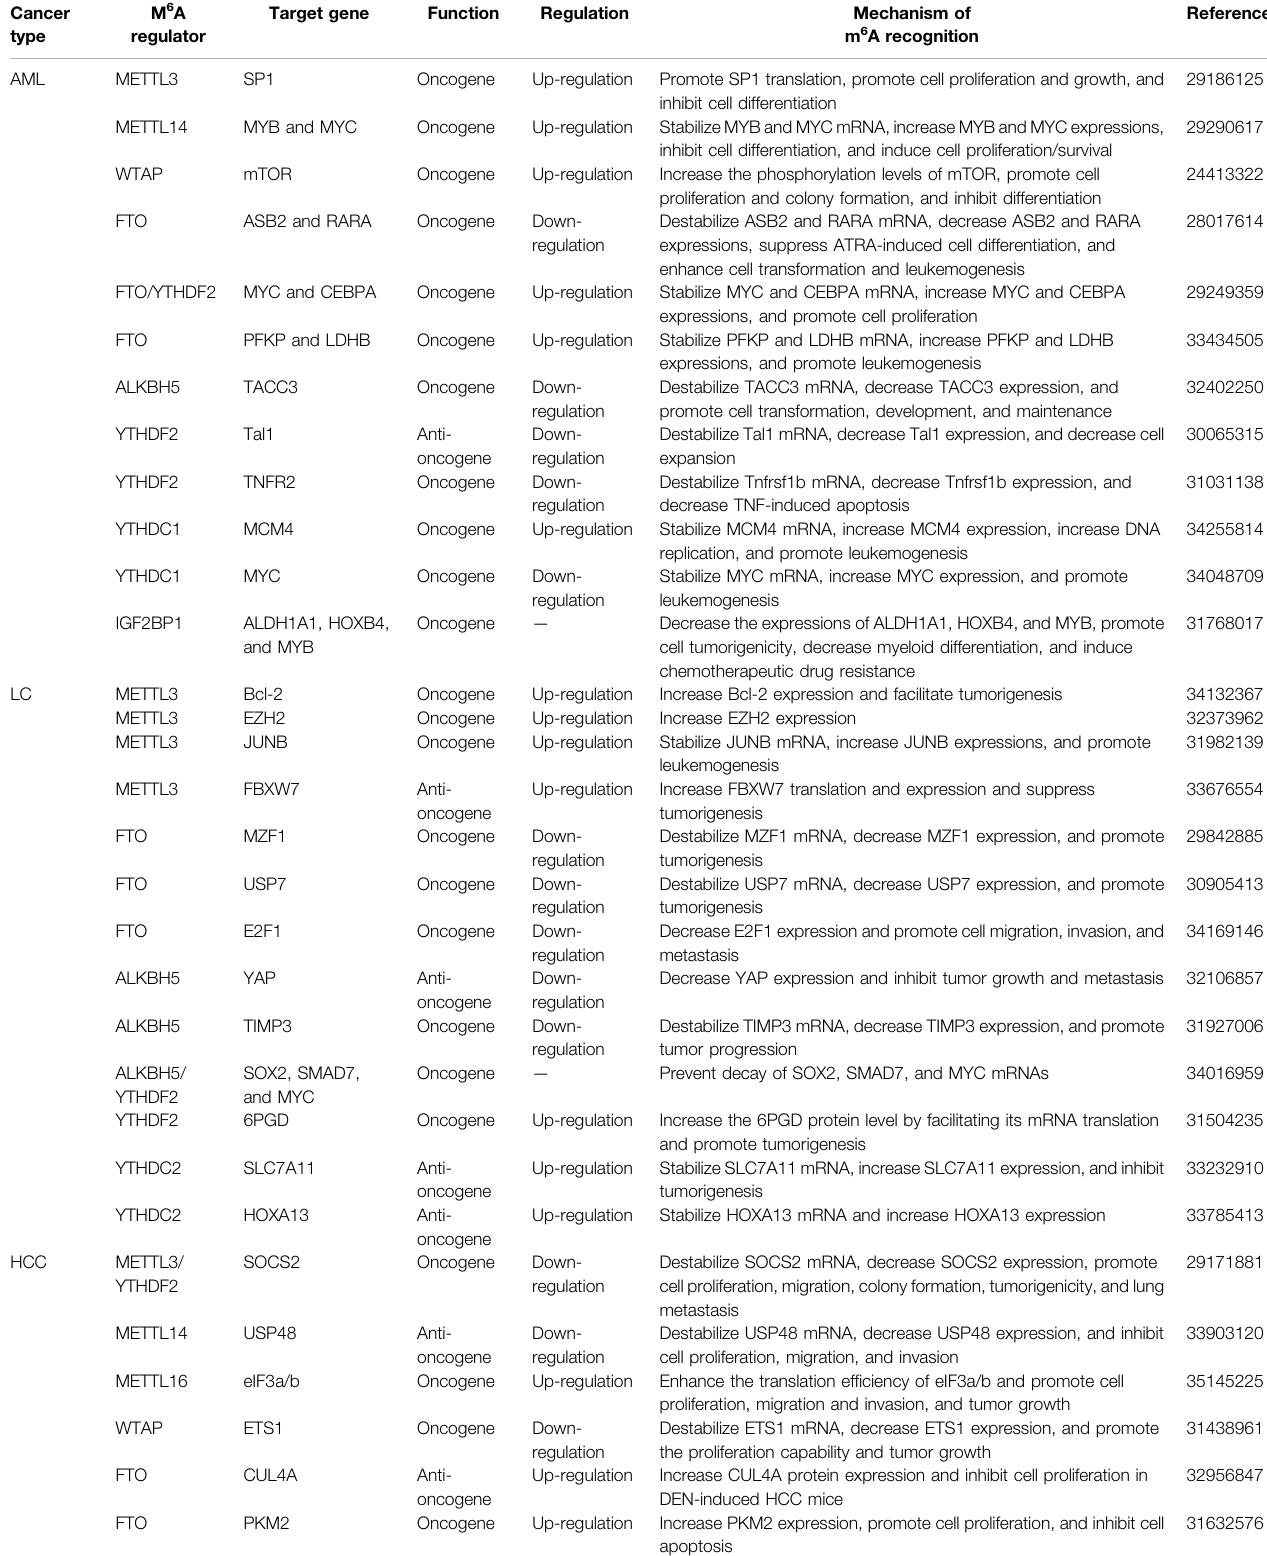
TABLE 1 | Roles of aberrant m 6 A modi fi cation in various cancers. Cancer